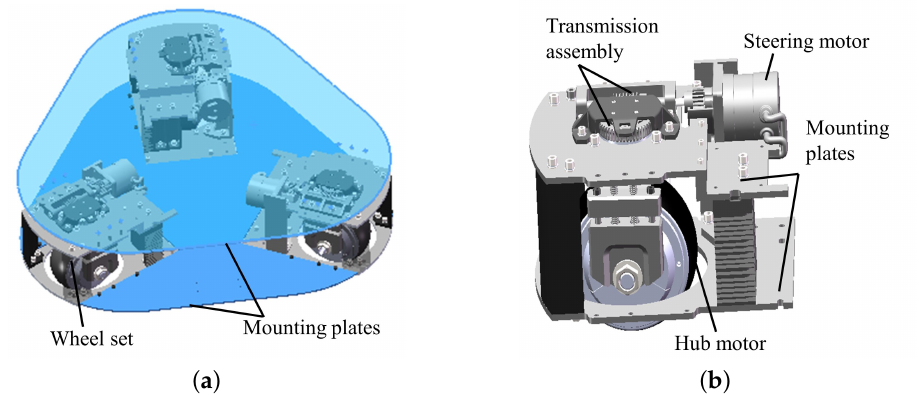
Figure 3. Construction of a modular omnidirectional mobile chassis. ( a ) Overall structure. ( b ) Mecha- nism of a single wheel